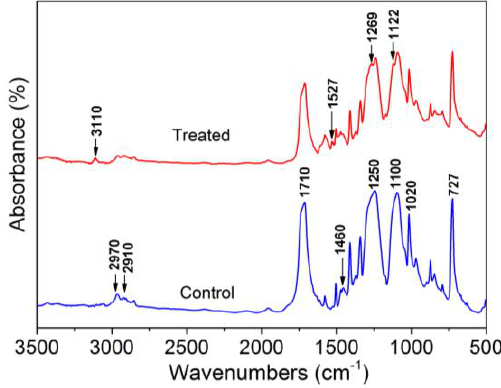
Figure 4. FT-IR spectra of untreated and optimal PANI-coated PET sample yarns.